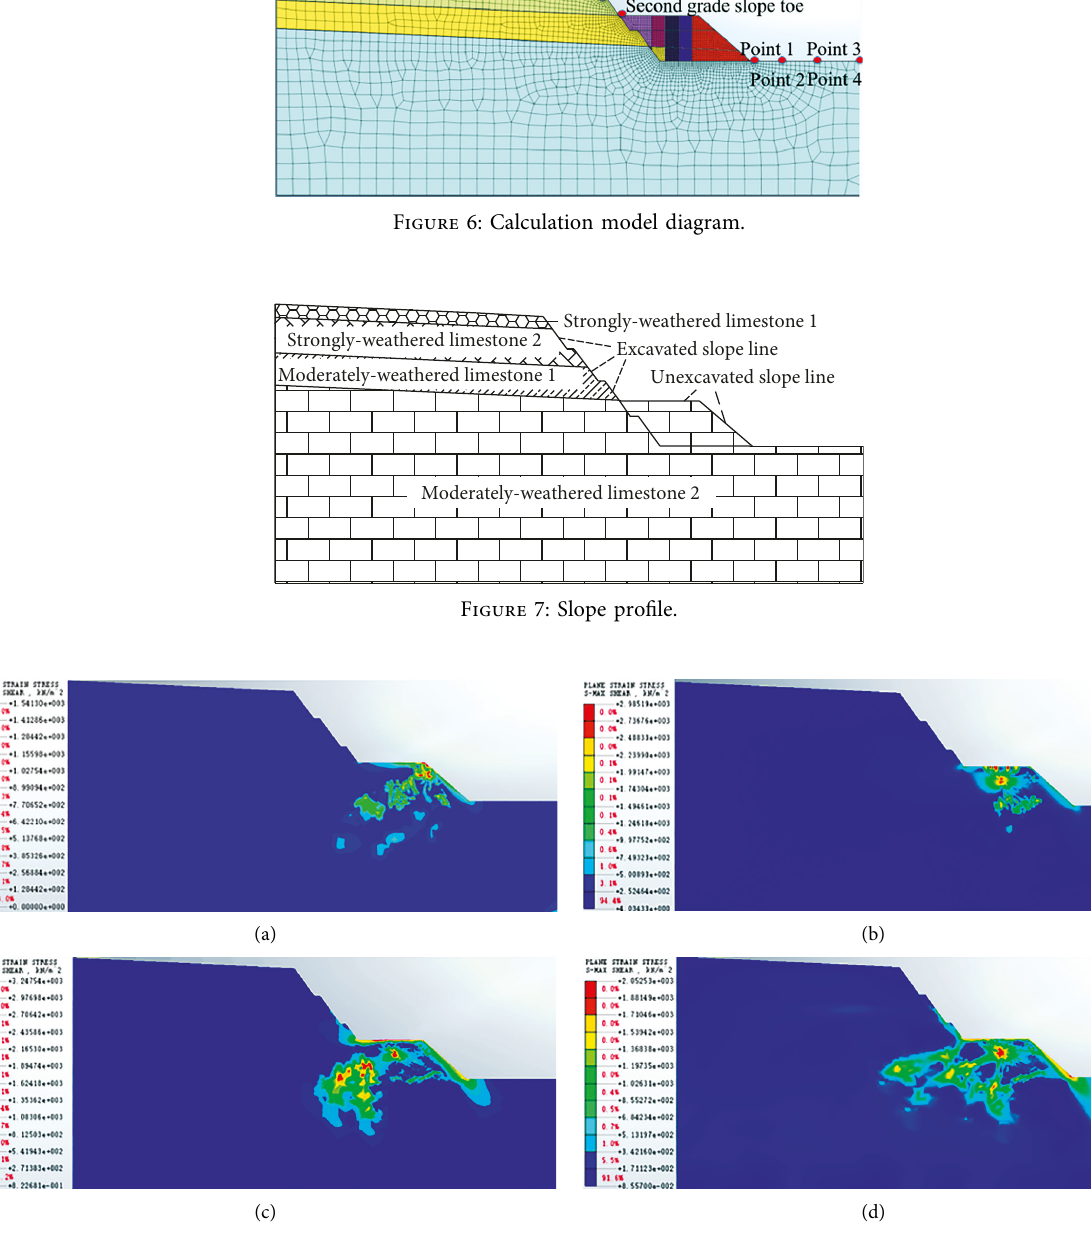
Figure 8: Slope stress field nephogram at different blasting periods. (a) 75 ms. (b) 150 ms. (c) 225ms. (d)